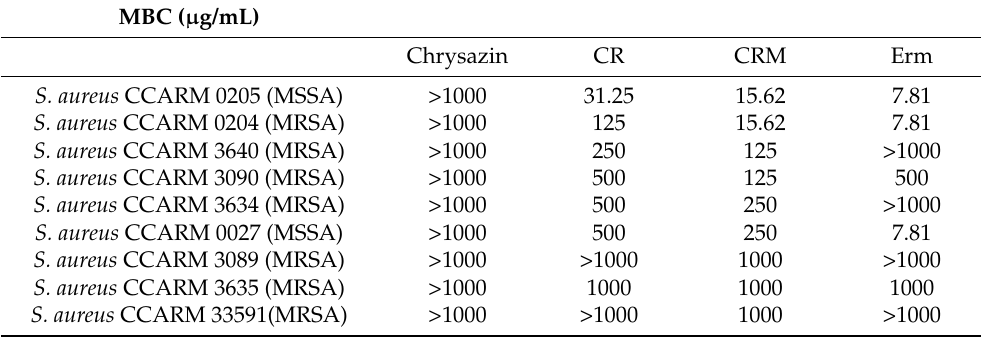
Table 3. MBC values of compound chrysazin, CR, CRM, and erythromycin (Erm) against 9